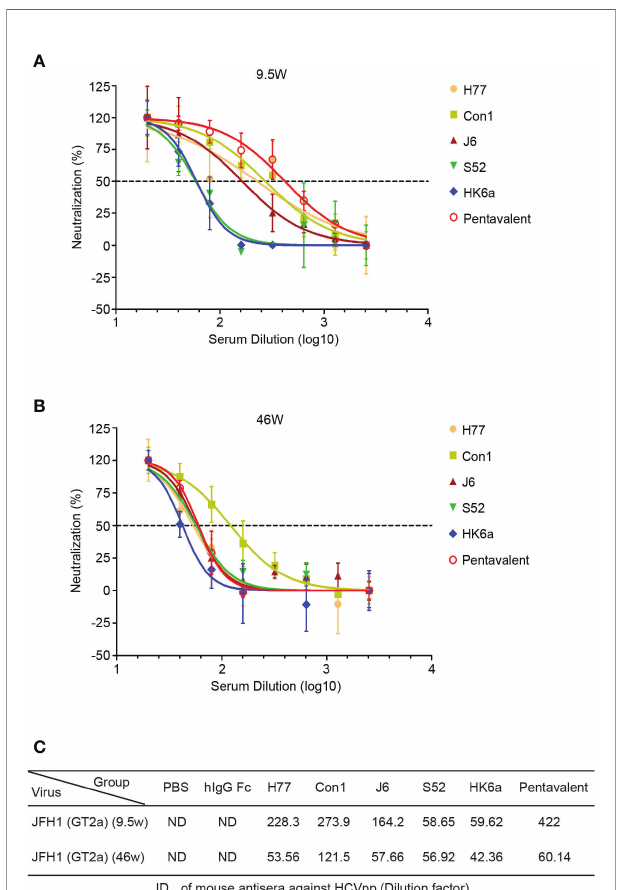
FIGURE 7 | Duration of neutralization activities of the pentavalent and monovalent Fc-E1E2 vaccines in mice. (A, B) Neutralization curve against HCVcc of the week 9.5- and week 46-vaccinated sera, respectively. Sera from each group were serially diluted two times from 20 to 2560 for the neutralization test. The neutralization curves were fi tted with a nonlinear regression model to calculate the ID 50 values. (C) ID 50 of antisera. ID 50 was de fi ned as the dilution of sera able to neutralize 50% of HCVcc infectivity, and the ID 50 values were calculated by GraphPad Prism. HCVcc, cell culture- derived HCV, ID 50 , 50% inhibitory